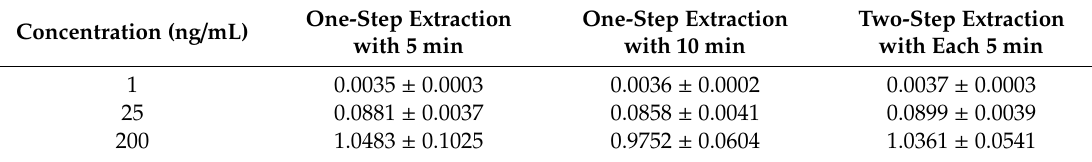
Table 1. The peak area ratios (celastrol (CL) / IS) obtained from investigation of di ff erent extract conditions for celastrol determination in rat plasma ( n =